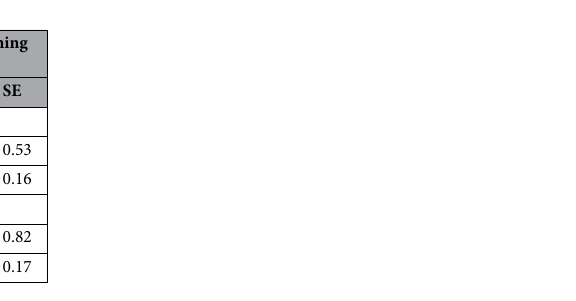
Table 2. Regression coefficients and standard errors for lung and heart volumes for Landrace and Duroc on age and weight at scanning date.